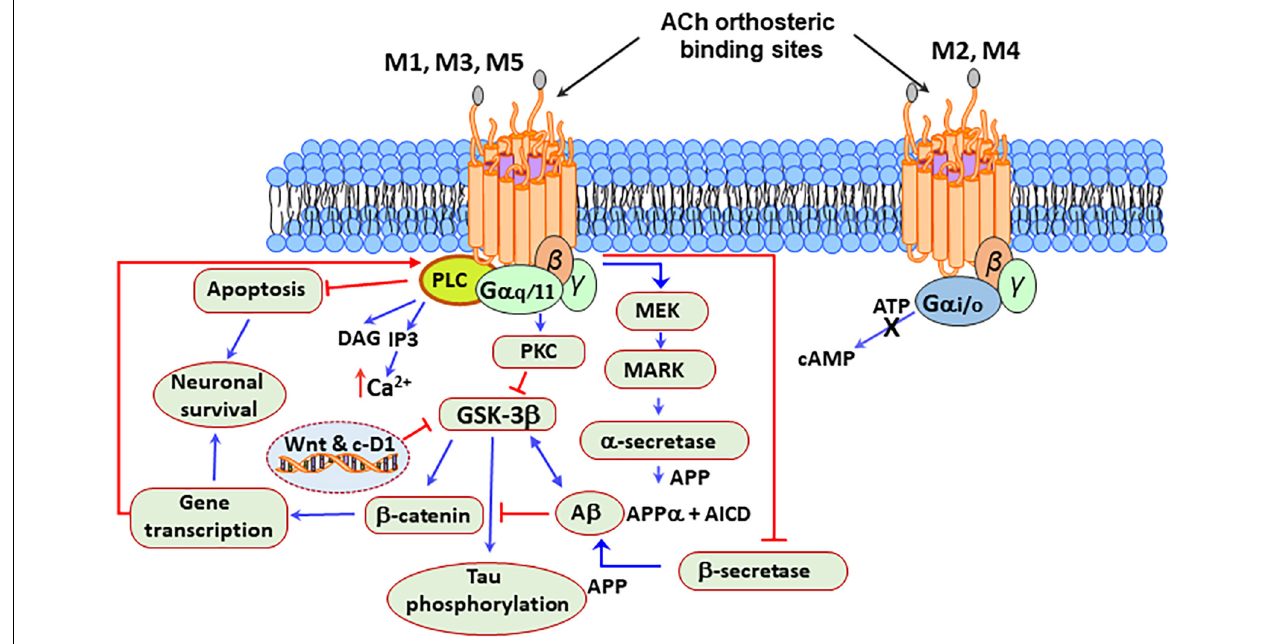
FIGURE 3 | Neuroprotective signaling pathways stimulated by the mAChRs. M1, M3, and M5 mAChRs are associated with the Gq/11 subfamily of G proteins, which are responsible for the increase of cytosolic Ca 2 + , activation of phospholipase C (PLC) and protein kinase C (PKC), which leads to the production of signaling molecules inositol triphosphate (IP3) and diacylglycerol (DAG). Acetylcholine (ACh) activation of the M2 and M4 receptors, which are associated with the Gi/o subfamily of G proteins, increases the opening time of potassium channels and decreases the production of adenosine-3 (cid:48) ,5 (cid:48) -cyclic monophosphate (cAMP). Besides, the stimulation of the M1 mAChRs by agonists or ACh increases the production of sAPP α and decreases the production of amyloid A β peptide. Protein kinase C (PKC) and the extracellular signal-regulated protein kinase (ERK)1/2 are involved in this process by activating α -secretases. The activation of the M1 mAChRs counteracts A β -induced neurotoxicity via the Wnt signaling pathway, as A β inhibits this pathway through the destabilization of β -catenin. In contrast, stimulation of M1 mAChR inactivates glycogen synthase kinase 3 (GSK3 β ) via PKC activation, thus stabilizing β -catenin and inducing the expression of the Wnt-targeting and cyclin-D1 genes for neuronal